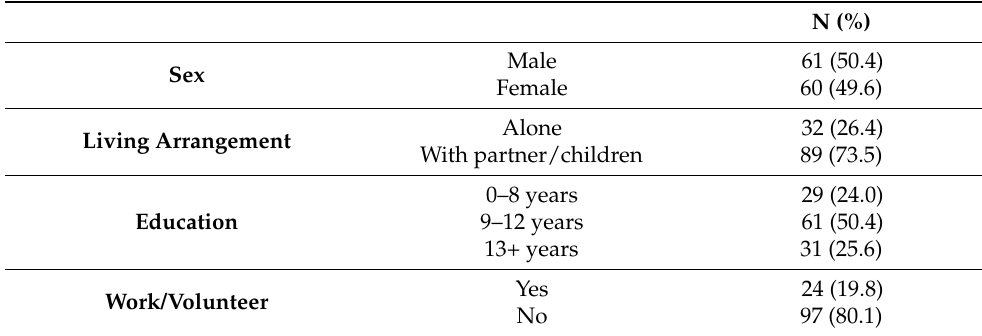
Table 1. Demographic data of the older adults (N = 121).